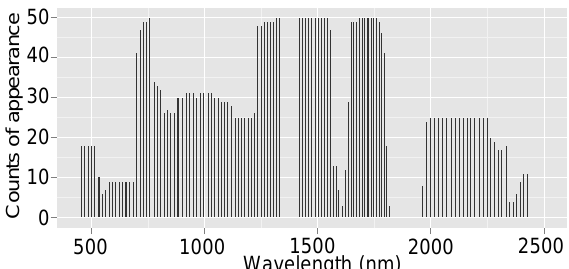
Figure 7. Accumulated number of each spectral bands selection in 50 times cross-validation by fused lasso regression